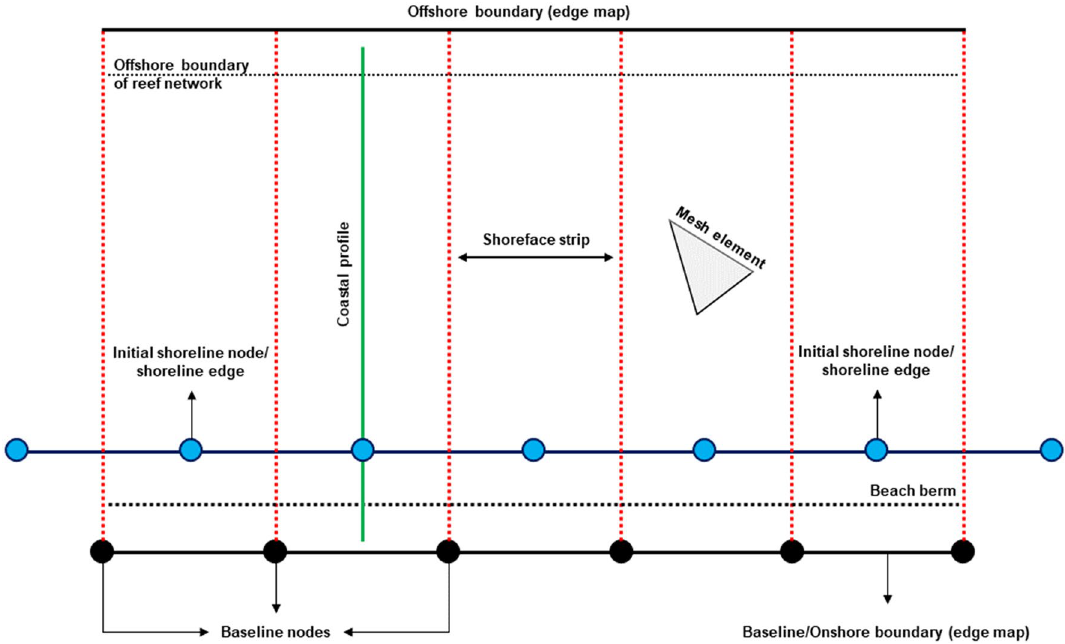
Figure 6. Computational setup of MIKE21 SM. MIKE21 SM uses an edge map that divides the shoreface into strips. Each strip has one active coastal profile and one shoreline edge. The active coastal profile in each shoreface strip moves with the shoreline edge perpendicular to the baseline, based on the total change in sediment volume within the strip. The spacings between two baseline nodes determine the resolution of the initial shoreline and longshore width of each shoreface strip. The onshore boundary of the edge map is the baseline, whereas the offshore boundary is the depth contour seaward of the closure